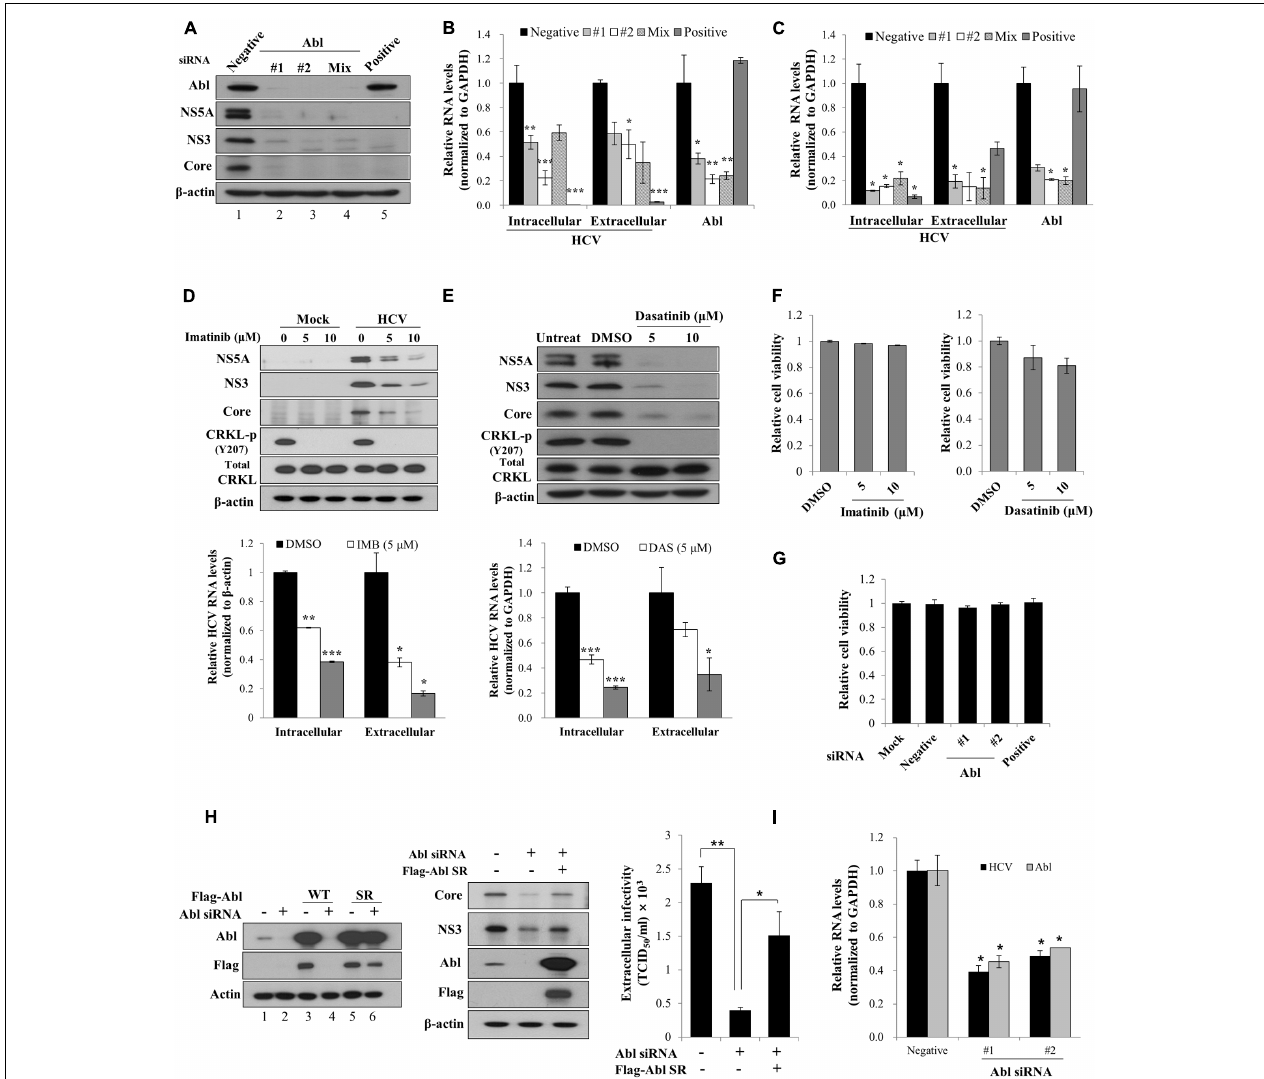
FIGURE 1 | Abl is required for HCV propagation. (A) Huh7.5 cells were transfected with 10 nM concentration of the indicated siRNAs. At 48 h after transfection, cells were then infected with Jc1 for 4 h using an MOI of 0.5. Total cell lysates harvested at 48 h post-infection were immunoblotted with the indicated antibodies. Negative denotes universal negative control siRNA. Positive indicates HCV-specific siRNA targeting the 5 (cid:48) NTR of Jc1. (B) Huh7.5 cells were treated as described in (A) and then RNA levels of both HCV and Abl were quantified by qRT-PCR. Experiments were carried out in triplicate. The asterisks indicate significant differences ( ∗ P < 0.05; ∗∗ P < 0.01, ∗∗∗ P < 0.001). Error bars indicate the standard deviations of the means. (C) Huh7.5 cells were transfected with 10 nM concentration of the indicated siRNAs. At 48 h after transfection, cells were then infected with H77D for 4 h. At 48 h post-infection, RNA levels of both HCV and Abl were analyzed by qRT-PCR. (D) (Upper panel) Huh7.5 cells pretreated with imatinib were either mock-infected or infected with Jc1 for 4 h. Cells were further incubated with either DMSO (vehicle) or two different doses of imatinib for 48 h. Total cell lysates were immunoblotted with the indicated antibodies. (Lower panel) Both intracellular and extracellular HCV RNA levels were determined by qRT-PCR. (E) (Upper panel) Huh7.5 cells were pretreated with either DMSO or two different doses of dasatinib and then infected with Jc1 for 4 h. Cells were further incubated with either DMSO or dasatinib for 48 h. Total cell lysates were immunoblotted with the indicated antibodies. (Lower panel) Both intracellular and extracellular HCV RNA levels were determined by qRT-PCR. Experiments were performed in triplicate. The asterisks indicate significant differences ( ∗ P < 0.05; ∗∗ P < 0.01, ∗∗∗ P < 0.001). (F) Huh7.5 cells were treated with either DMSO or two different doses of imatinib (left panel) or dasatinib (right panel). Forty-eight hours after inhibitor treatment, cell viability was determined by a WST assay. (G) Huh7.5 cells were transfected with 20 nM of the indicated siRNAs. At 72 h after transfection, cell viability was determined by a WST assay. (H) (Left panel) Huh7.5 cells were transfected with p3XFlag-Abl wild-type (WT) or p3XFlag-Abl siRNA-resistant (SR) expression plasmid. At 24 h after transfection, total cell lysates were immunoblotted with the indicated antibodies. (Middle panel) Huh7.5 cells were transfected with either negative siRNA or Abl-specific siRNA. At 24 h transfection, cells were further transfected with Flag-tagged Abl SR plasmid for 24 h and then infected with Jc1 for 4 h. Cell lysates harvested at 2 days post-infection were immunoblotted with the indicated antibodies. (Right panel) Naïve Huh7.5 cells were inoculated with the supernatant harvested from experiment described in the middle panel. At 2 days post-infection, cells were fixed with methanol and HCV infectivity was determined by TCID50 assay. (I) Primary human hepatocytes were transfected with negative siRNA or Abl-specific siRNAs. At 2 days after transfection, cells were infected with Jc1 for 4 h. Cells were harvested at 2 days post-infection and then intracellular RNA levels of HCV and Abl were determined by